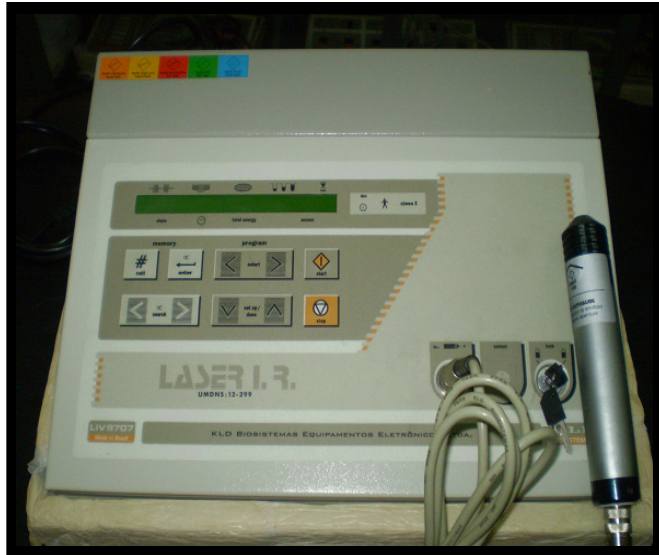
FIGURE 2 – GaAs Laser equipment, extension of wave of 904nm. Source: Fieldwork archive, 2010.